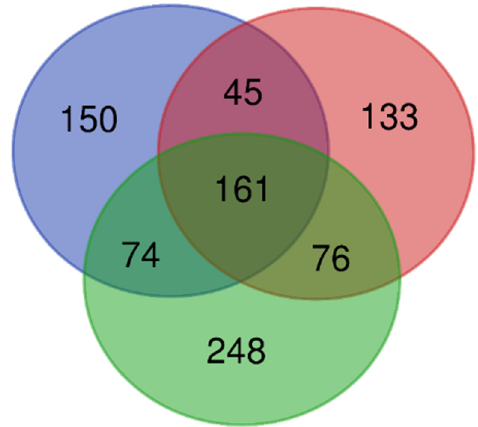
Figure 6. Venn diagram indicating the diversity of the fungal OTUs found in the mature forests, clear-cuts, and 4th year plantations, and the number of fungal OTUs shared across studied sites; the data obtained in three study sites (A, L, and V) were combined. Different colours represent different study sites: blue indicates mature forest stands, red—clear-cuts, and green—4th year plantations.